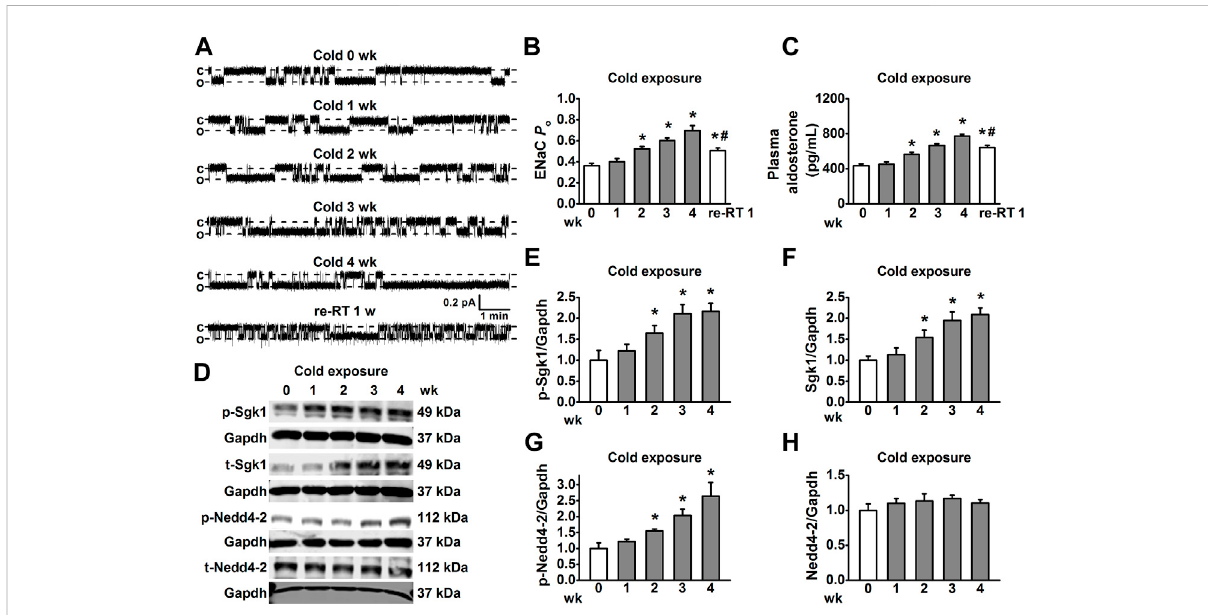
FIGURE 2 ColdexposureincreasedEnNaCactivityinMAendothelialcellsandaldosterone-mediatedSgk1/Nedd4-2activation. (A) RepresentativeEnNaC single-channel currents recorded in endothelial cells of acute split-open MAs; MAs were prepared, respectively, from control rats and the cold exposed rats (1, 2, 3, 4 weeks, and re-RT 1 week; c indicates a closed level and o represents an open level). (B) Demonstration of the summarized P O values obtained from the single-channel recordings as shown in (A) . P O values re fl ect the EnNaC activity ( n = 5 – 7 for each group; * p < 0.05 vs control; # p < 0.05 vs cold exposure 4 weeks). (C) Demonstration of the plasma aldosterone levels in SD rats measured under the indicated conditions and time points ( n = 5 for each group; * p < 0.05 vs. control; # p < 0.05 vs. cold exposure 4 weeks). (D – H) Representative Western blot images of p-Sgk1, t-Sgk1, p-Nedd4-2, and t-Nedd4-2 in MAs, isolated from rats under each indicated experimental condition and time points